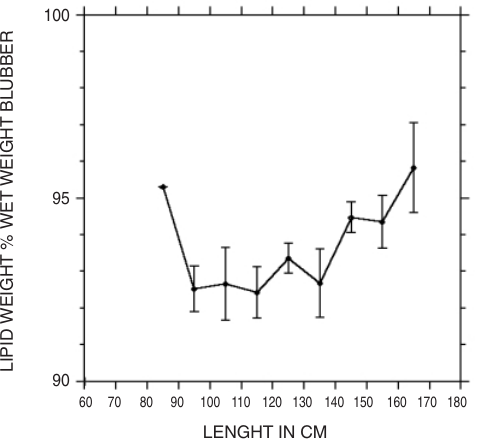
Fig. 11. Mean ± S.E. percentage wet weight of blubber lipid in harbour porpoises.